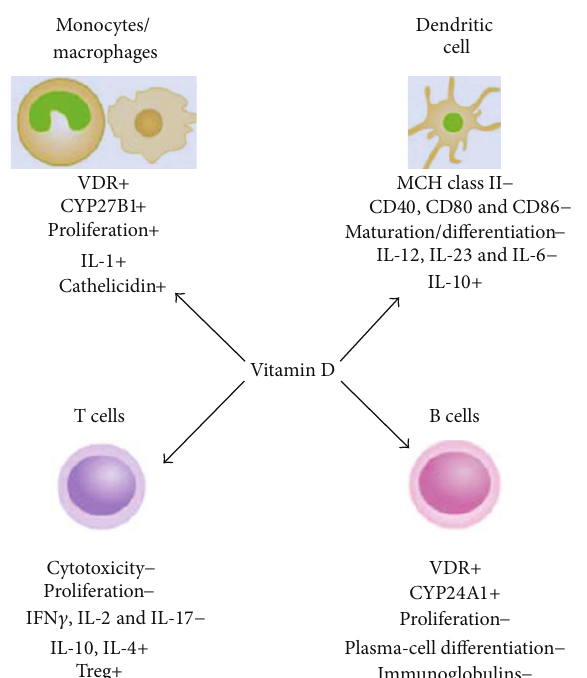
Figure 1: Effects of vitamin D on different immune system cells. Vitamin D regulates several immune system cell functions. It stimulates monocyte proliferation and differentiation towards macrophage-like cells, by self-increasing VDR, CYP27B, and IL-1 expressions; this “fast- forward” autocrine mechanism seems to be the basis for the subsequent maturation into macrophages, which does not take place in vitamin D deficient conditions; macrophage specific surface antigen expression is also enhanced. Vitamin D prevents T cells from proliferation, maturation, and releasing Th1-type molecules, such as IFN 𝛾 , IL-2, and IL-17, whereas it promotes Treg development. Vitamin D treatment prevents DCs from maturation and differentiation as well, by MHC class II, costimulatory factors, and interleukin downregulation. Vitamin D-induced protolerogenic DCs seem to be the key event for suppressive effects on immunesystem cells. Downregulation of B cell proliferation and maturation seems to be an indirect consequence of the suppressive effect exerted by vitamin D on T cells and APC. (+) and ( − ) indicate induction or